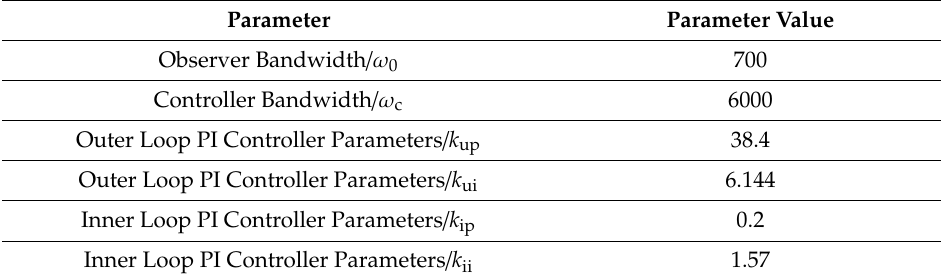
Table 2. Controller